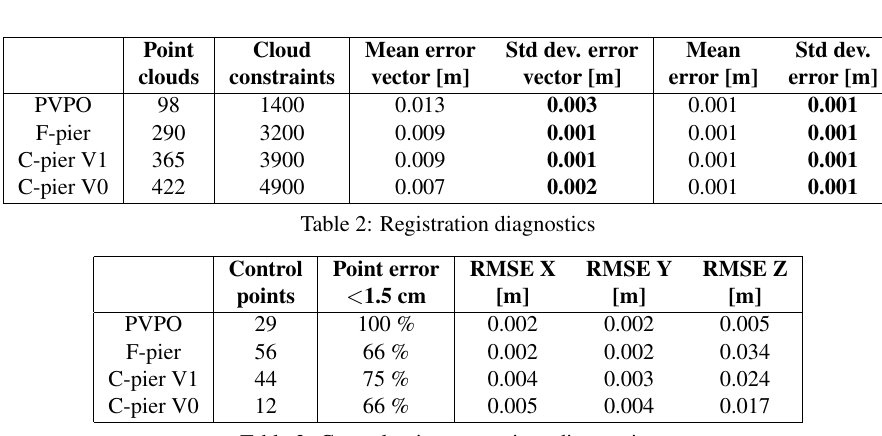
Table 3: Control point comparison